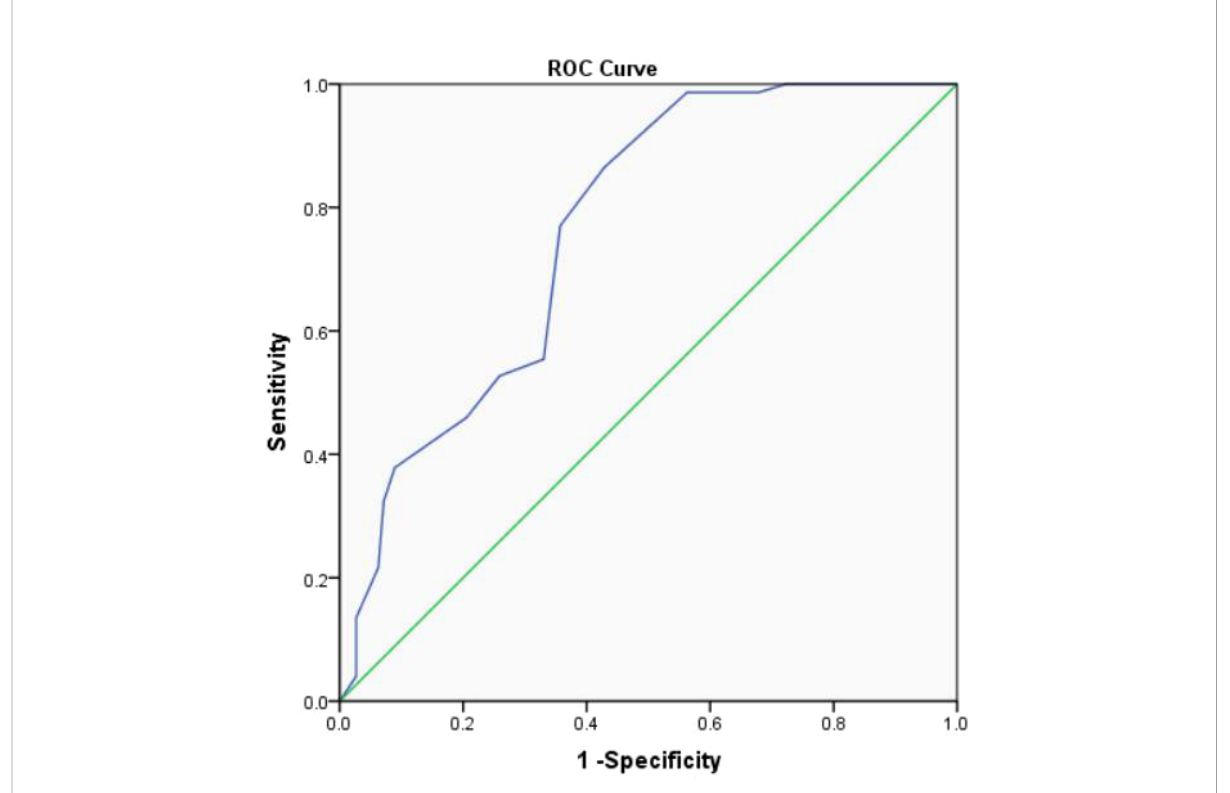
FIGURE 3 The ROC curve analysis to predict the optimal cyst size for clinical signi fi cance EUS-FNA (the area under the